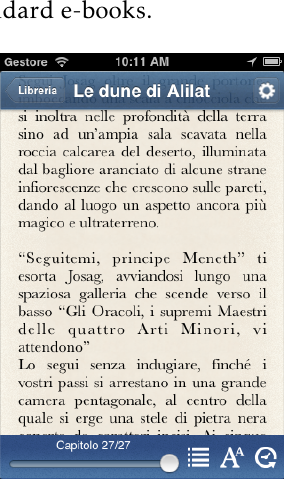
Figure 8. Reading interface (with